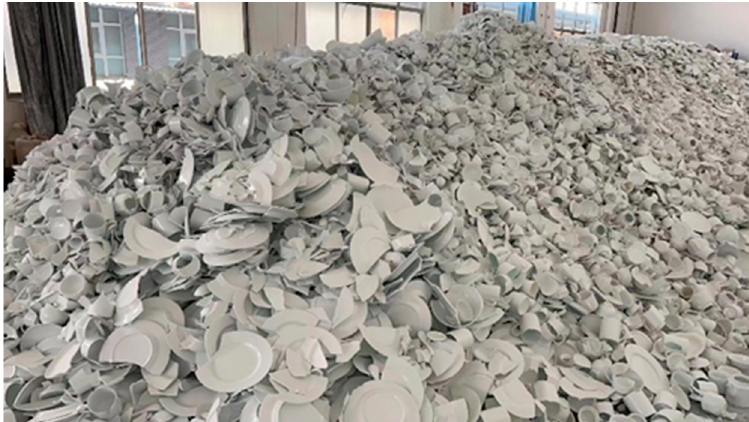
Figure 1. Photo of the used ceramic waste.